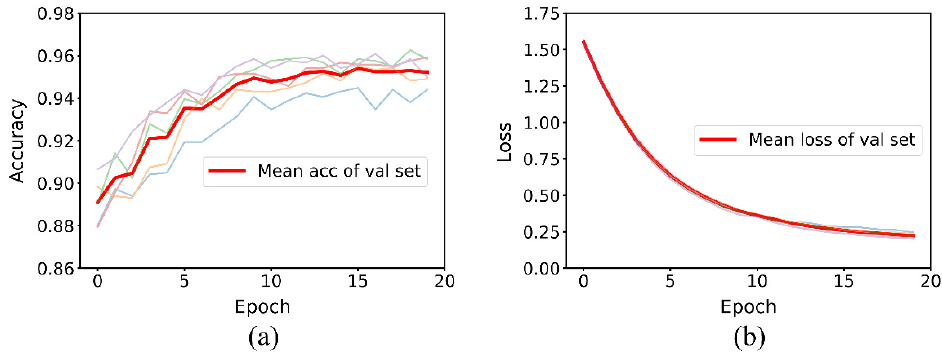
Figure 10. Five test results of MDF-PNet. ( a ) The accuracy curve and ( b ) the loss curve.